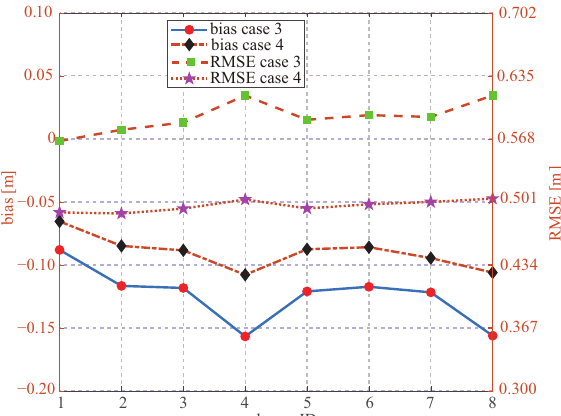
Figure 12. Biases and RMSEs between the retrieved SWH and ECMWF data for different spcae- borne platforms.